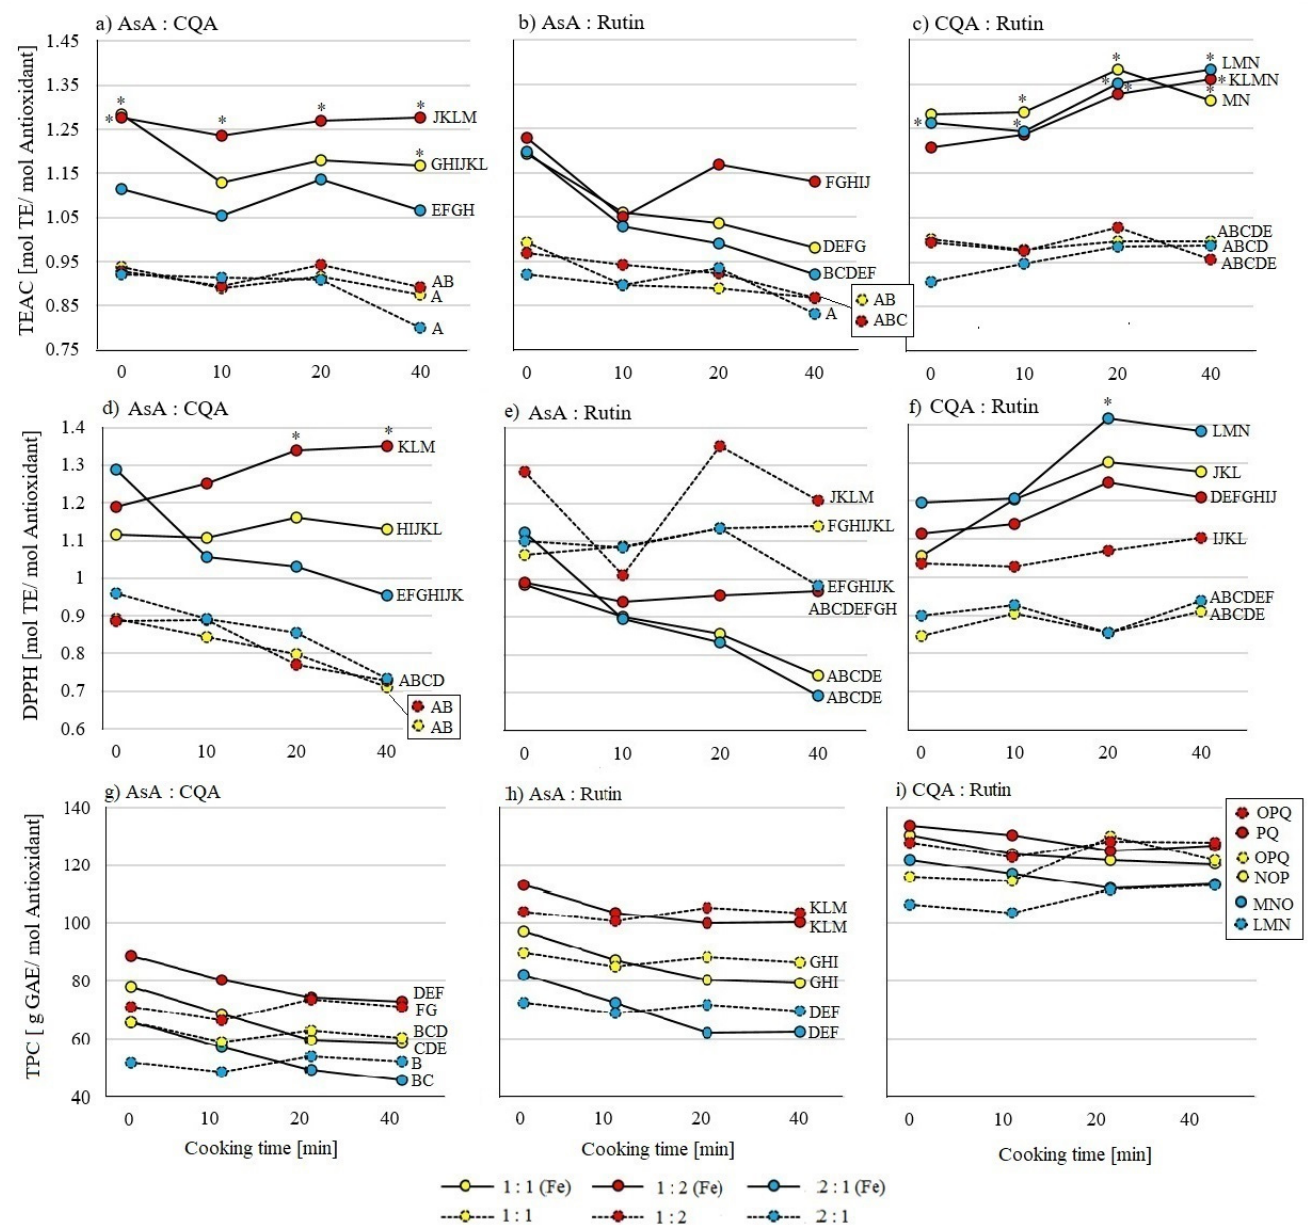
Figure 2. Influence of cooking time (0, 10, 20, and 40 min) on binary mixtures of ascorbic acid (AsA), 5-caffeoylquinic acid (CQA), quercetin-3-rutinoside (Rutin) with (solid lines) and without (dashed lines) iron (Fe) on antioxidant activity (AOA); standard deviation not shown. All samples tested using ( a – c ) TEAC, ( d – f ) DPPH, and ( g – i ) TPC assays. Colors indicate the different mixing ratios: equimolar mixtures are yellow, 1:2 ratios are red, and 2:1 ratios are blue. Significant differences ( p ≤ 0.05 by Tukey’s HSD test ( n = 3)) within different cooking times of the same substance and between samples with and without iron are marked with an asterisk *. Differences to 0 min cooked samples of the same substance are marked with a triangle ▲ . Letters indicate differences between substance mixtures and ratios as mean values over all measured times and are comparable to results of the same test assay in Figures 1 and 3.